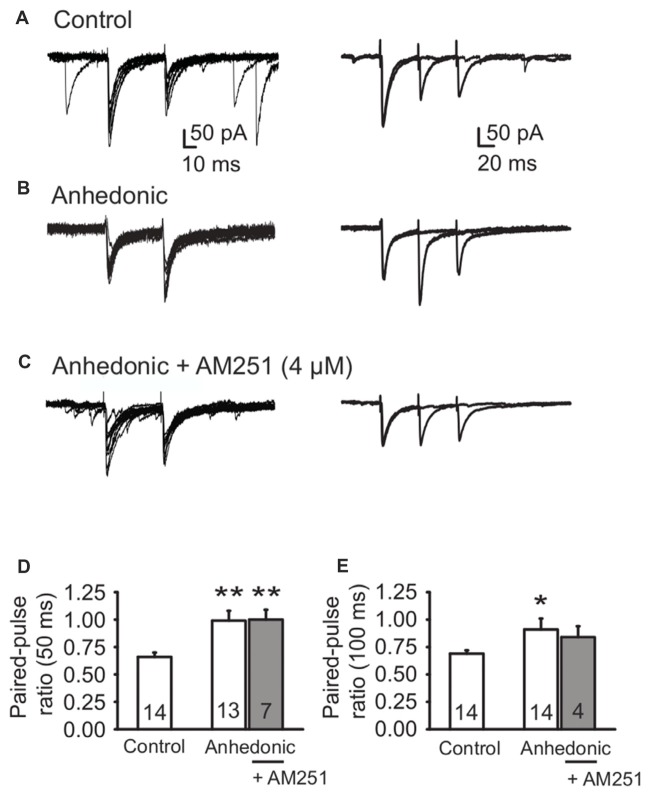
Altered release of GABA from perisomatic synapses in anhedonic rats. (A) Representative whole-cell patch-clamp recording of evoked IPSCs (eIPSCs) from a control rat. Paired-pulse depression of eIPSCs (amplitude of eIPSC2 relative to eIPSC1) was observed. Left panel (A) Individual traces of eIPSCs evoked by paired-pulse stimulation with 50 ms interpulse interval. Right panel (A) Superimposed average traces of eIPSCs evoked by paired-pulse stimulation with 50 ms interpulse interval and 100 ms interpulse interval, recorded from the same cell. (B) Representative recording from an anhedonic rat. The average eIPSC2/eIPSC1 ratio was increased for both interpulse intervals. Left panel (B) individual traces of eIPSCs evoked by paired-pulse stimulation with 50 ms interpulse interval. Right panel (B) superimposed average traces of eIPSCs evoked by paired-pulse stimulation with 50 ms interpulse interval and 100 ms interpulse interval, recorded from the same cell. (C) Representative recording from an anhedonic rat. The slice was incubated with the inverse agonist of CB1 receptors AM251 (4 μM) for 20 min. AM251 could not rescue the average eIPSC2/eIPSC1 ratios. Left panel (C) individual traces of eIPSCs evoked by paired-pulse stimulation (50 ms interpulse interval) in presence of AM251. Right panel (C) superimposed average traces of eIPSCs evoked by paired-pulse stimulation with 50 ms interpulse interval and 100 ms interpulse interval, recorded from the same cell, in presence of AM251. (D-E) Histograms showing paired-pulse ratio (PPR) (eIPSC2/eIPSC1) for interpulse interval of 50 ms (D) and 100 ms (E). All data are presented as the mean ± SEM. Statistics: t-test *p < 0.05, **p < 0.01 vs. control). The numbers of examined neurons are shown in the columns.